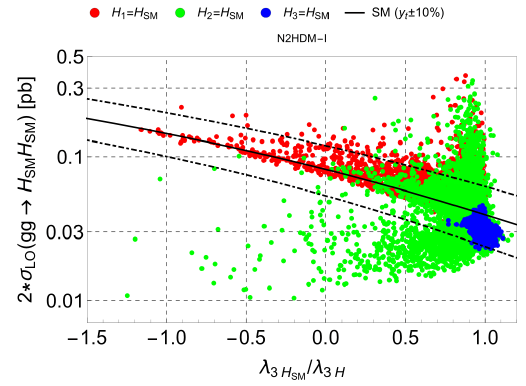
Figure 9 . N2HDM-I: SM-like Higgs pair production including a factor 2 to roughly account for the NLO QCD corrections, for H (red, green, blue), as a function of the trilinear SM- 1 , 2 , 3 ≡ H SM like Higgs self-coupling λ normalized to the SM value λ . The full line shows SM di-Higgs 3 H SM 3 H production as a function of λ . The dot-dashed lines show the additional change of this 3 H SM /λ 3 H cross section for a variation of y = 1 ± 0 . 1 t,H SM /y t,H